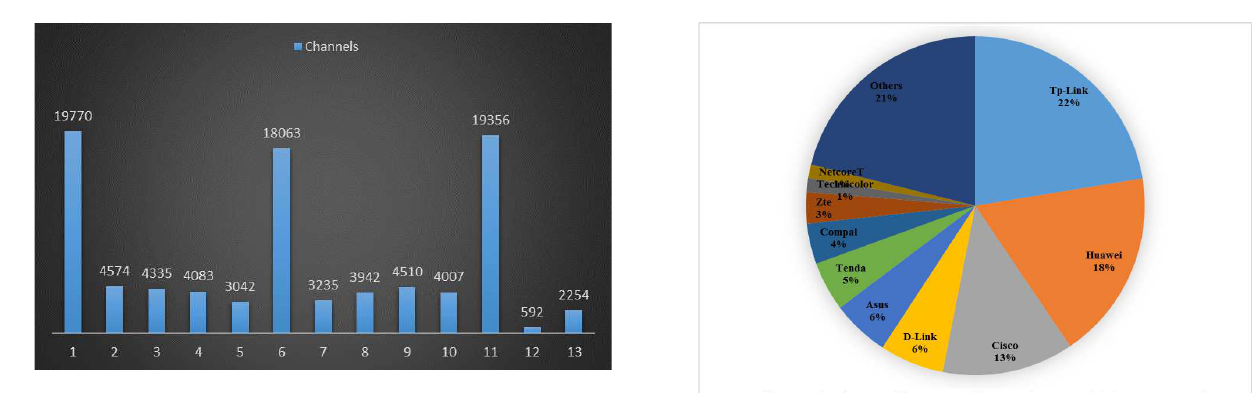
Figure 6. Channel usage in the 2.4 GHz band